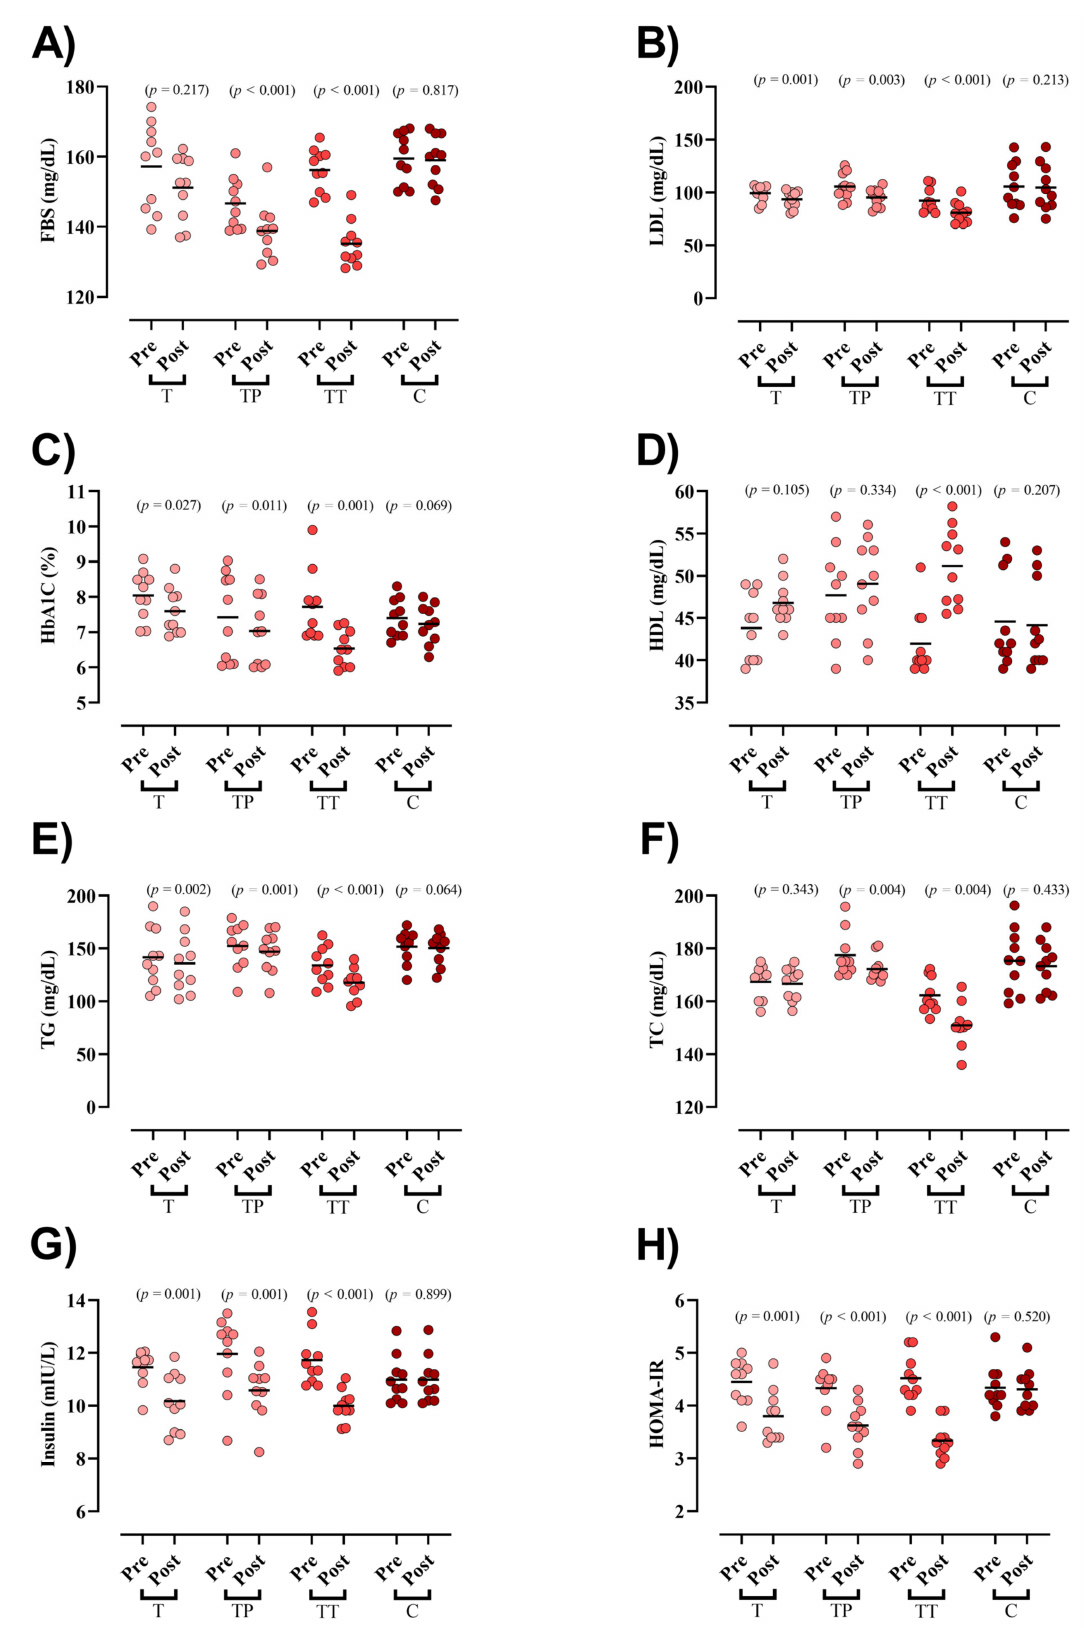
Figure 2. Serum markers of glucose and lipid markers. ( A ) FBS [fasting blood sugar]; ( B ) LDL [low-density lipopro- tein]; ( C ) HbA1c [Hemoglobin A1c]; ( D ) HDL [high-density lipoprotein]; ( E ) TG [triglyceride]; ( F ) TC [total cholesterol]; ( G ) Insulin; and ( H ) HOMA-IR, Homeostatic Model Assessment for Insulin